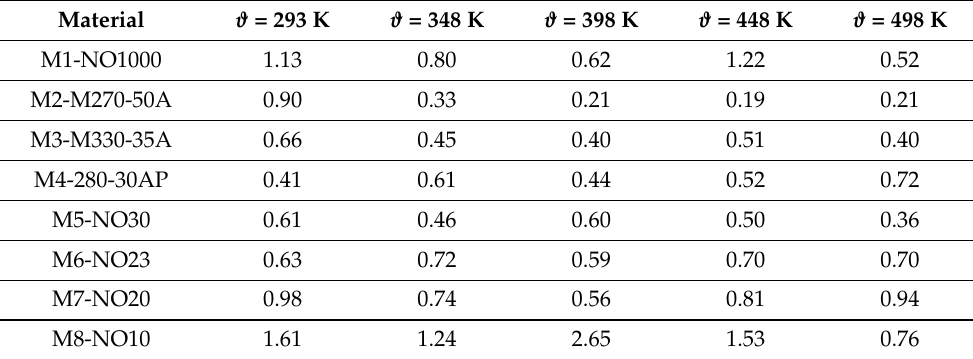
Table 4. Coefficient of variation cv for measurements of thermal diffusivity a in